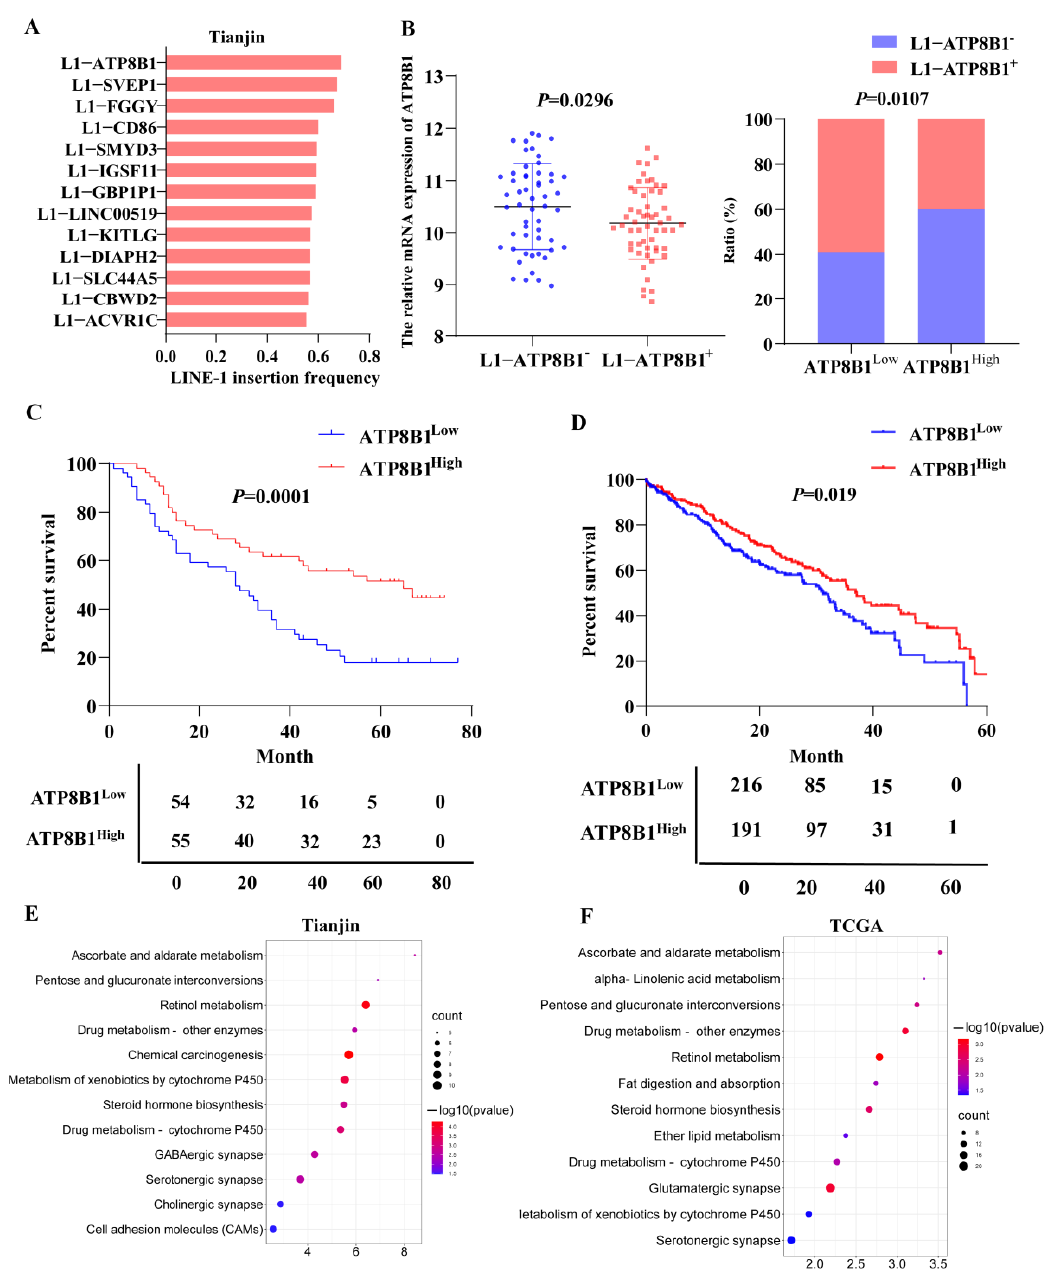
Figure 1. Low expression of ATP8B1 promotes poor prognosis for the tumor by regulating metabolism. ( A ) The frequency of 13 LINE-1 insertions in LUSC tissue samples from the TJMUCH cohort. The occurrence frequency of L1-ATP8B1 was the highest in the group with poor prognosis (survival time ≤ 40). ( B ) We divided LUSC samples from the TJMUCH cohort into L1-ATP8B1 + and L1- ATP8B1 − groups according to the relative mRNA expression level of L1-ATP8B1. The transcriptome sequencing data indicated that ATP8B1 mRNA expression was downregulated in the L1-ATP8B1 + group. In 109 LUSC tissues, ATP8B1 expression was divided into high- and low-expression groups according to the median of the expression values, and a high ratio of L1-ATP8B1 + samples was observed in ATP8B1 low tumor tissues. ( C ) Low expression of ATP8B1 was significantly associated with poor prognosis ( p = 0.0001). ( D ) Low expression of ATP8B1 was associated with poor prognosis in patients with LUSC at 5-year survival in the TCGA database ( p = 0.041). ( E ) Pathway enrichment of differentially expressed genes was associated with ATP8B1 in 109 tissues. ( F ) Pathway enrichment of differentially expressed genes was associated with ATP8B1 in the TCGA